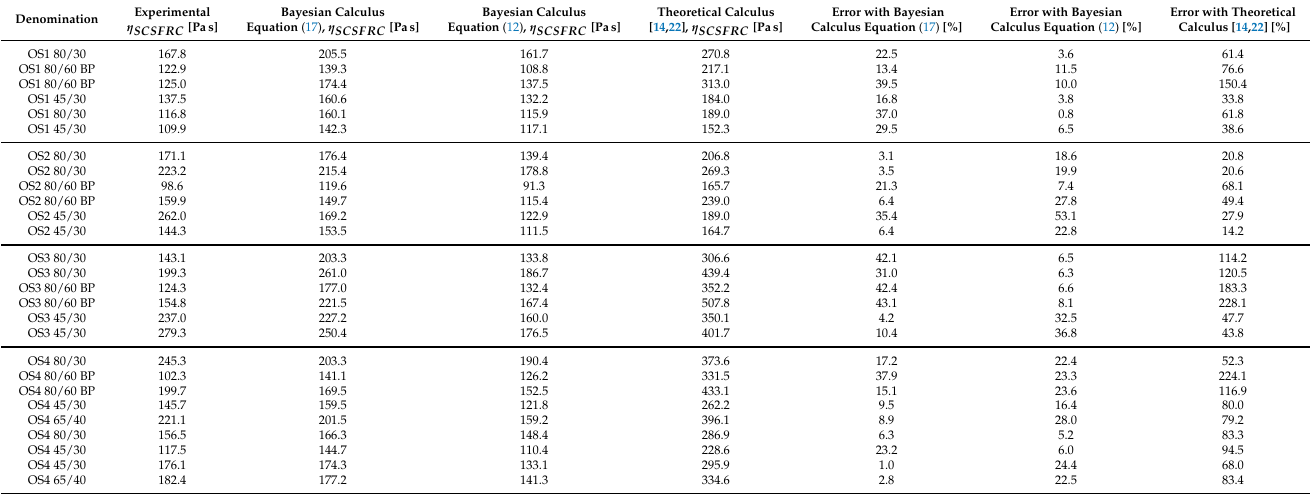
Table 5. Experimental values, models’ values and estimated error for SCSFRC (Grünewald [32]: Series OS1–OS4).